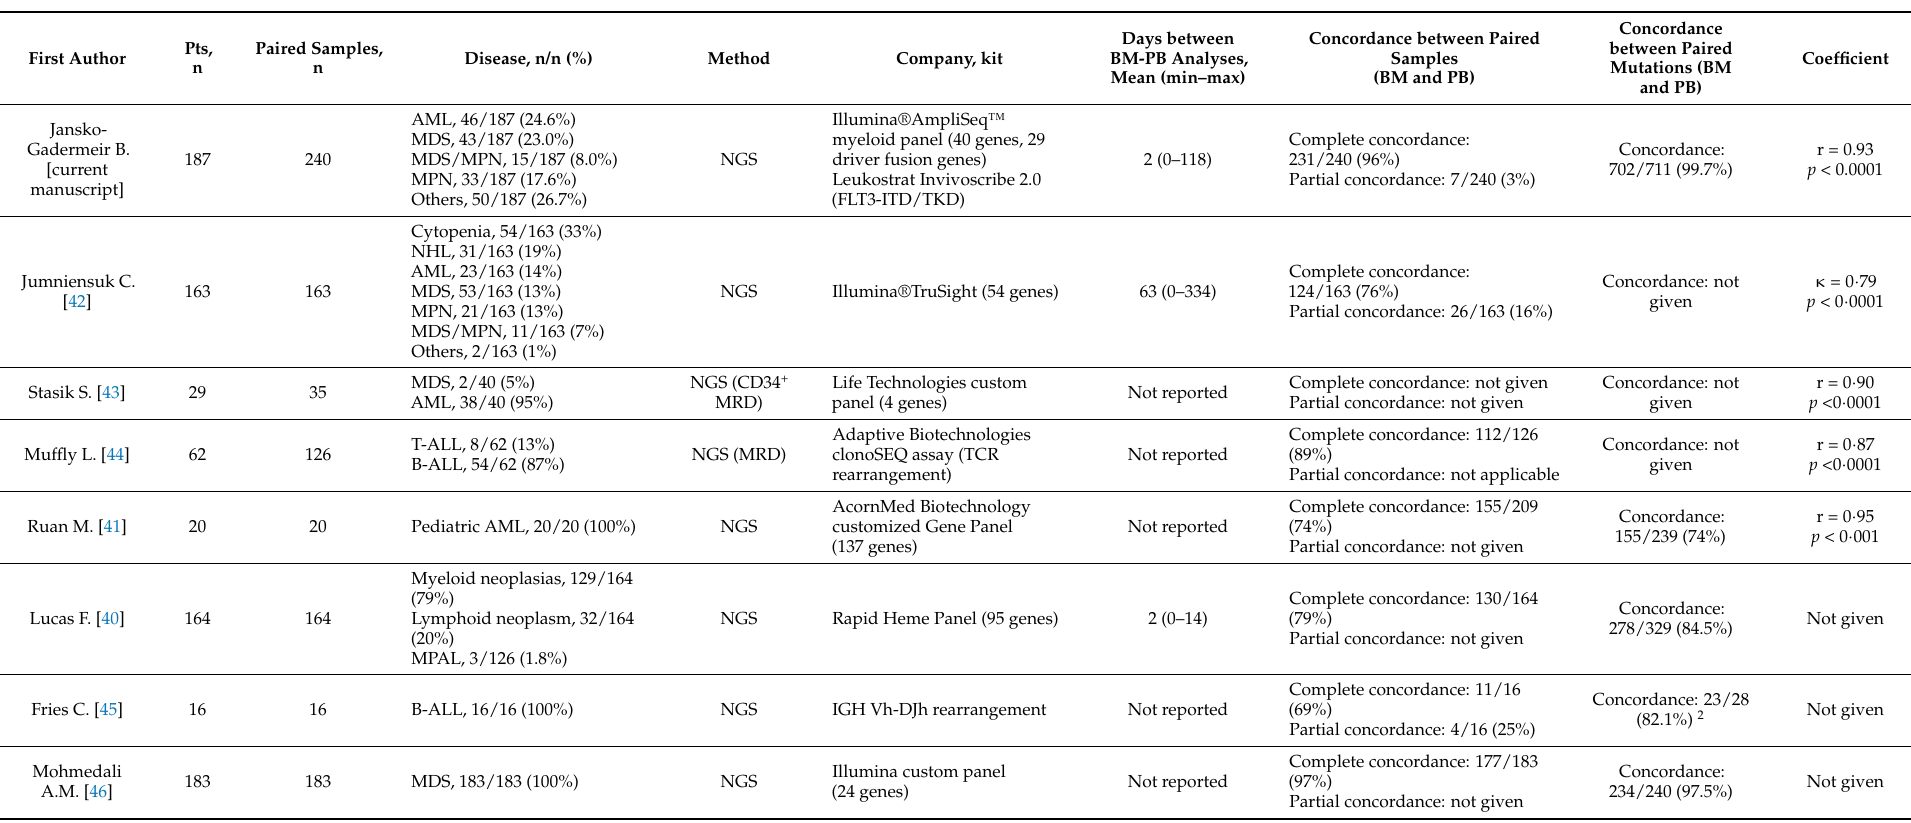
Table 1. Published articles comparing NGS analyses from bone marrow and peripheral blood in patients with MDS, CMML, and AML 1